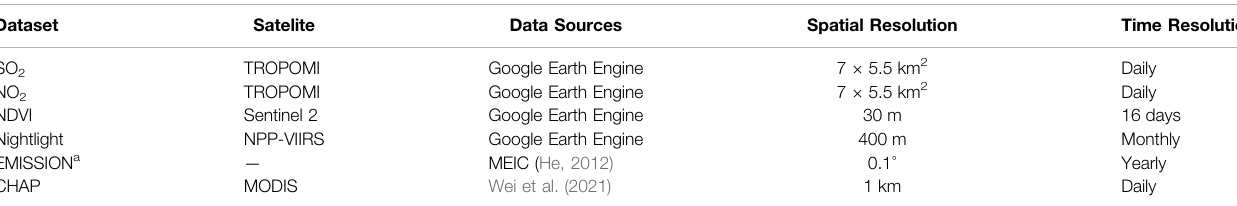
TABLE 1 | Datasets information used in this